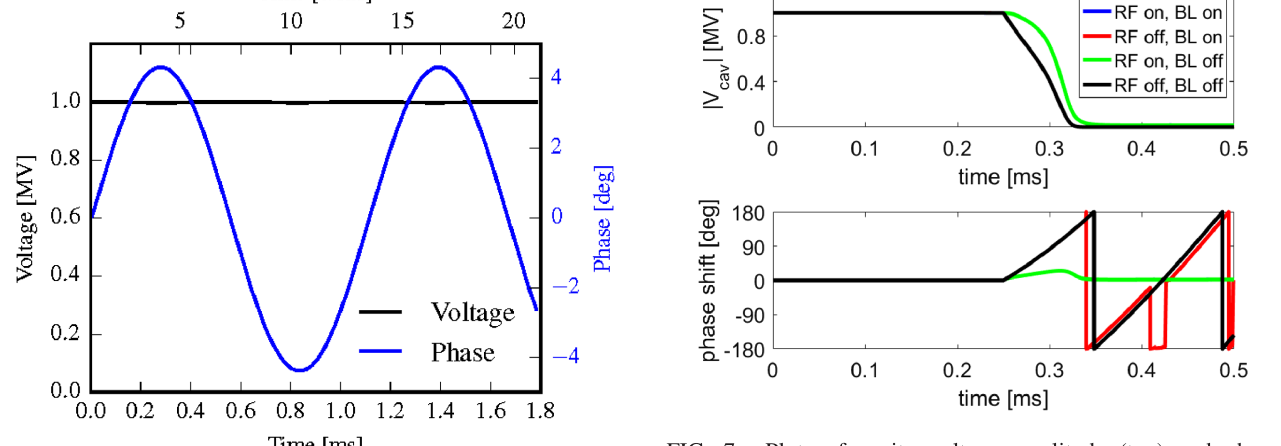
FIG. 7. Plots of cavity voltage amplitude (top) and phase (bottom) for a KEKB-like cavity at 4K during a quench, comparing the effects of the rf system and beam loading.